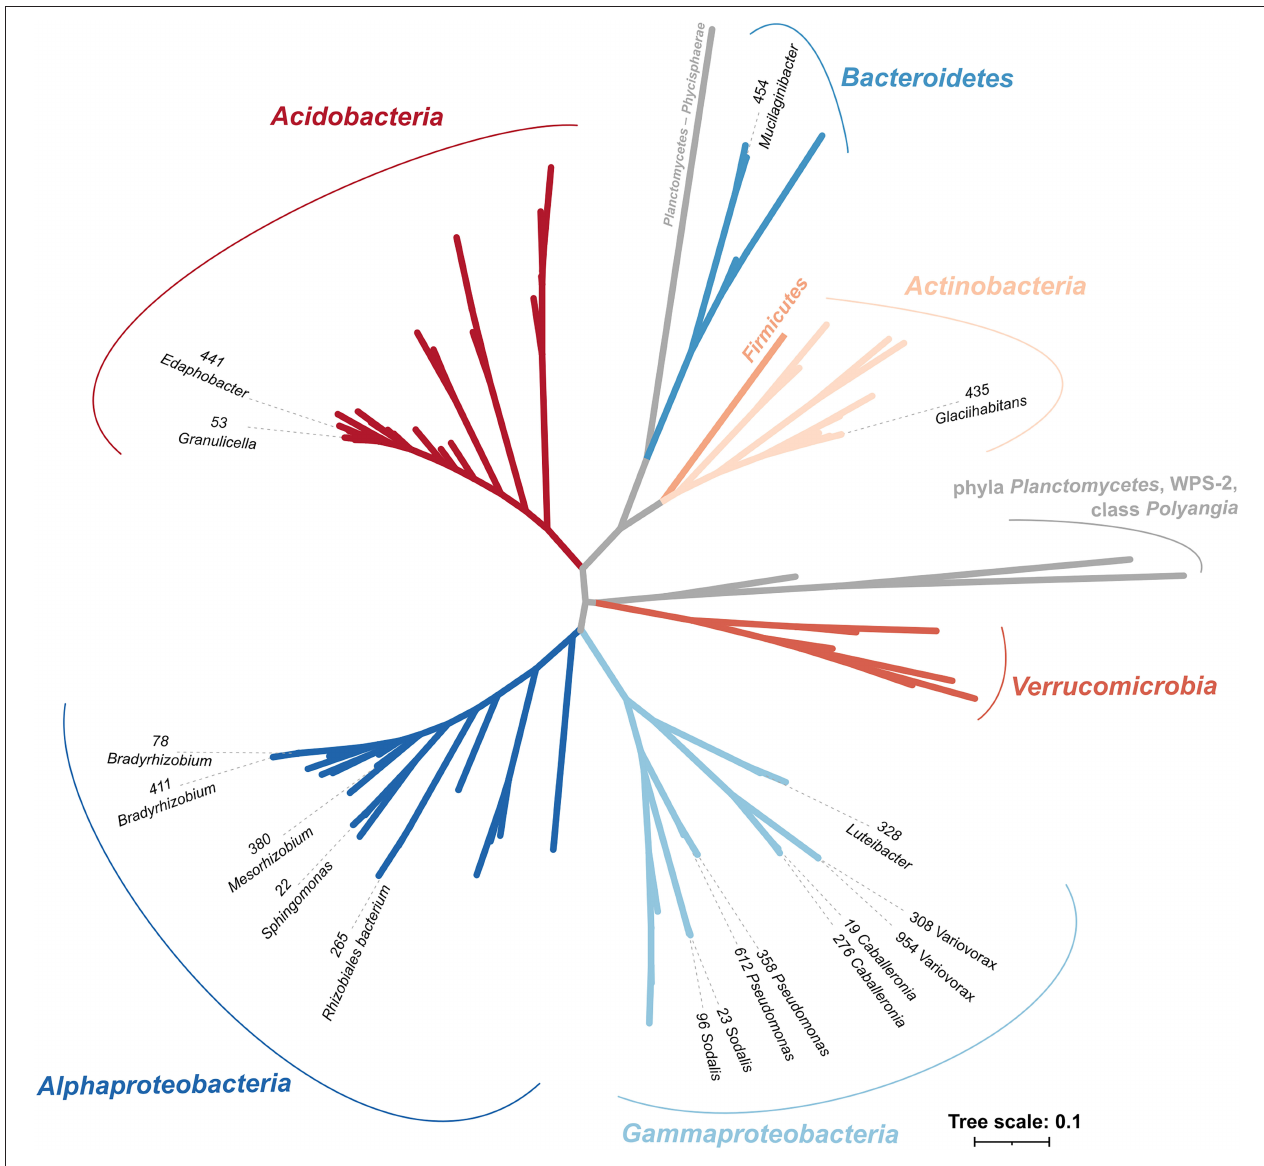
FIGURE 1 | Phylogenetic tree of strains with sequenced genomes in the context of representative sequences of the 87 most abundant OTUs from Fagus sylvatica , Picea abies , and Abies alba deadwood based on the V4 region of 16S rRNA gene. Strains are denoted with strain IDs and genus names and cover the majority of the dominant bacterial phyla in deadwood. Phyla are labeled with different colors, and taxonomy follows the SILVA 138 database. The most abundant bacteria are based on the study of Tláskal et al.